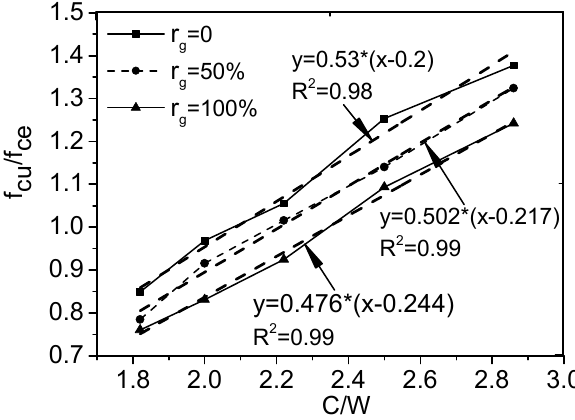
Figure 2. Relation between f cu / f ce and C/W.